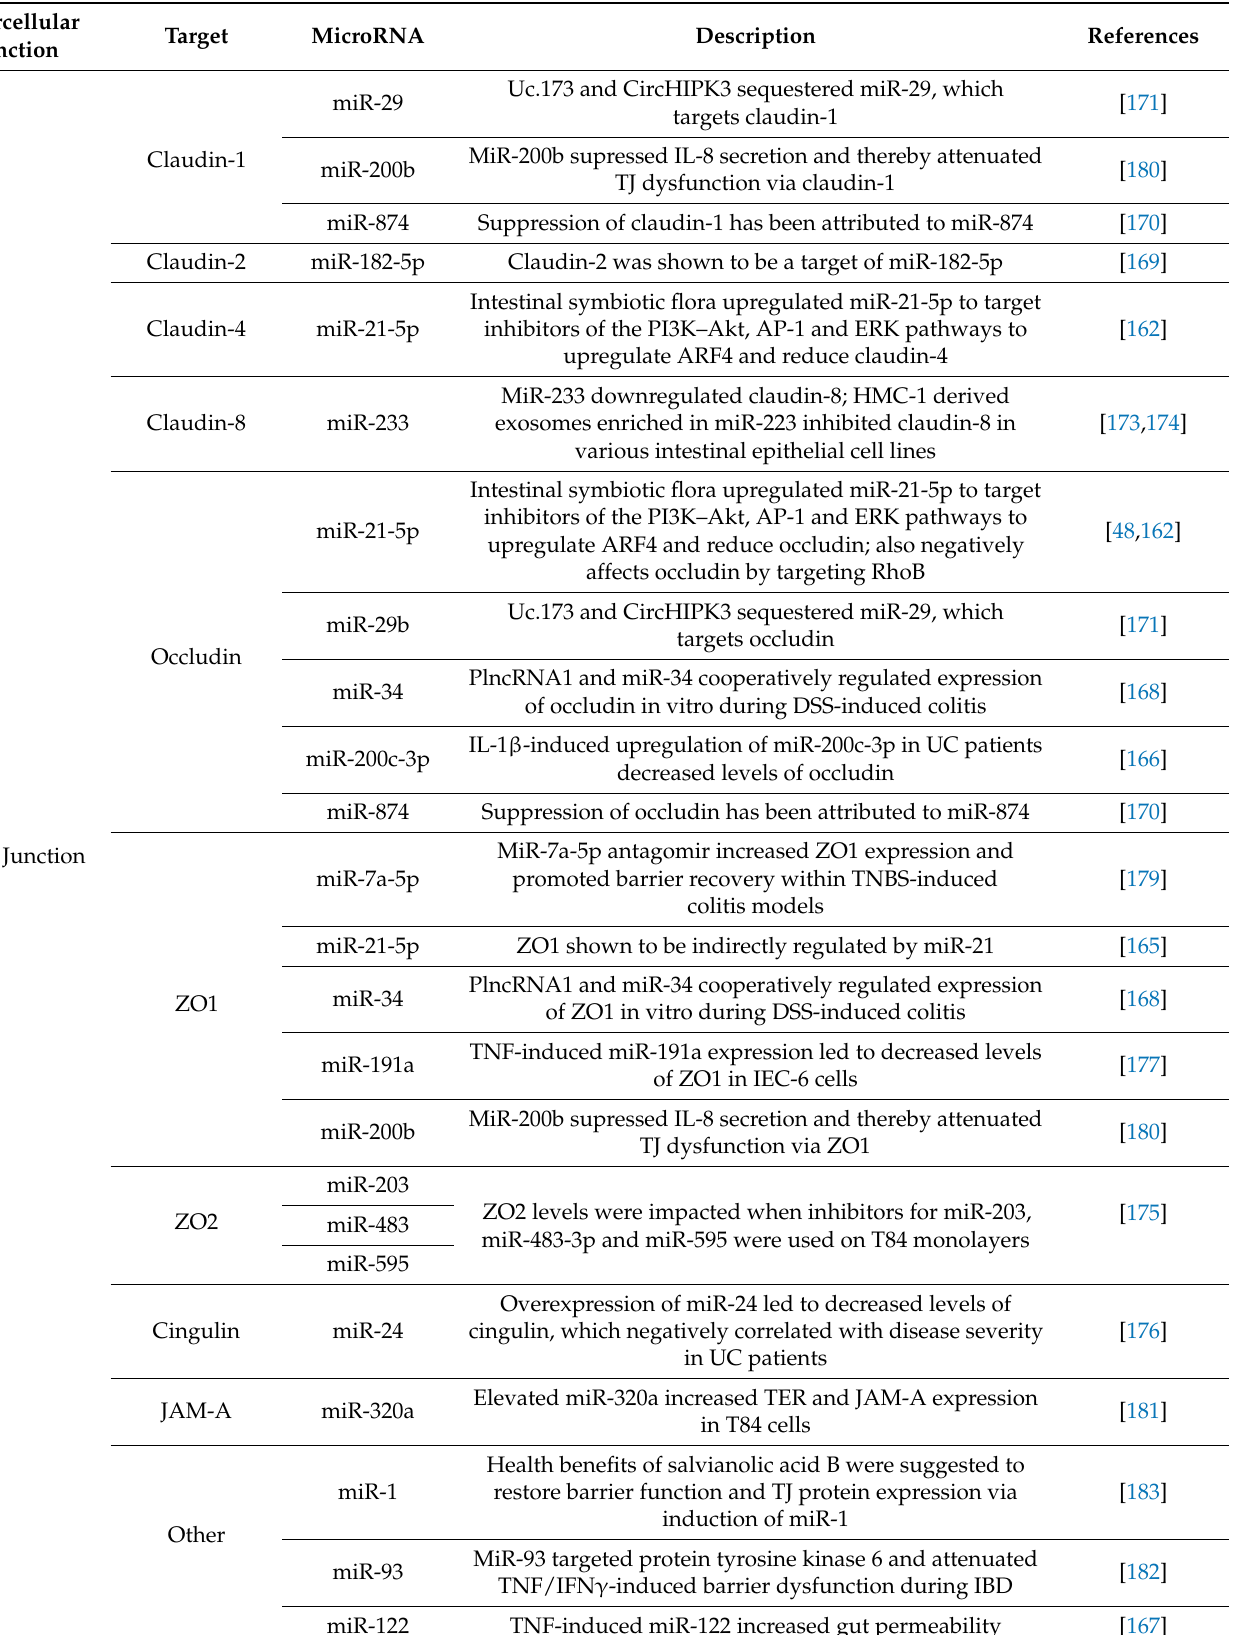
Table 2. Summary of literature demonstrating microRNA impact on intercellular junction